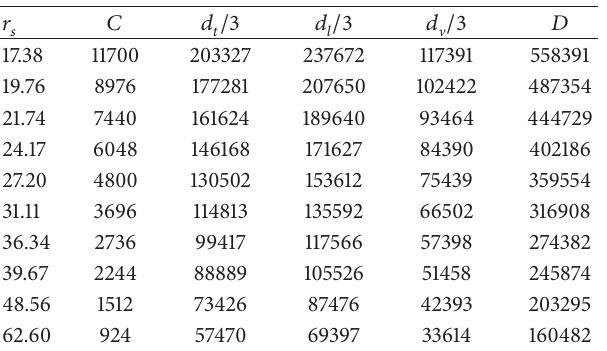
Table 3: Total distance traveled by the MSNs in fault tolerant traversal.